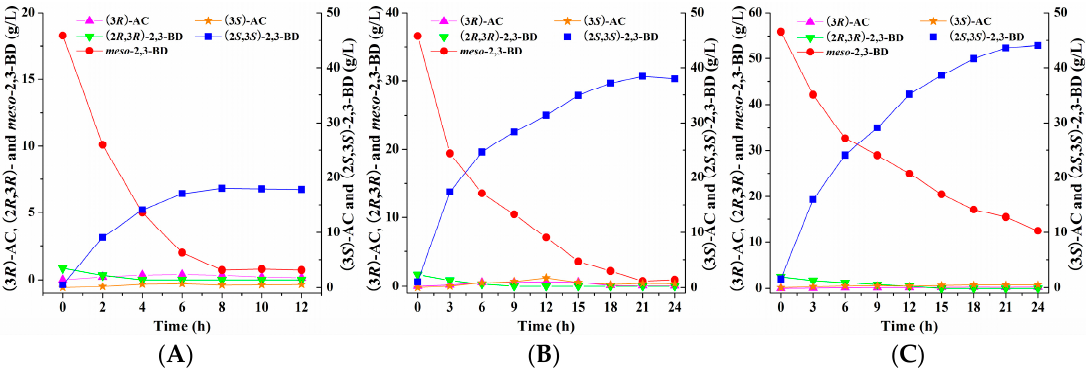
Figure 7. Time course of batch bioconversion of (2 S ,3 S )-2,3-BD production from meso -2,3-BD with the initial substrate concentration of 20 ( A ); 40 ( B ); and 60 ( C ) g/L by synchronous catalysis in 5-L bioreactor.